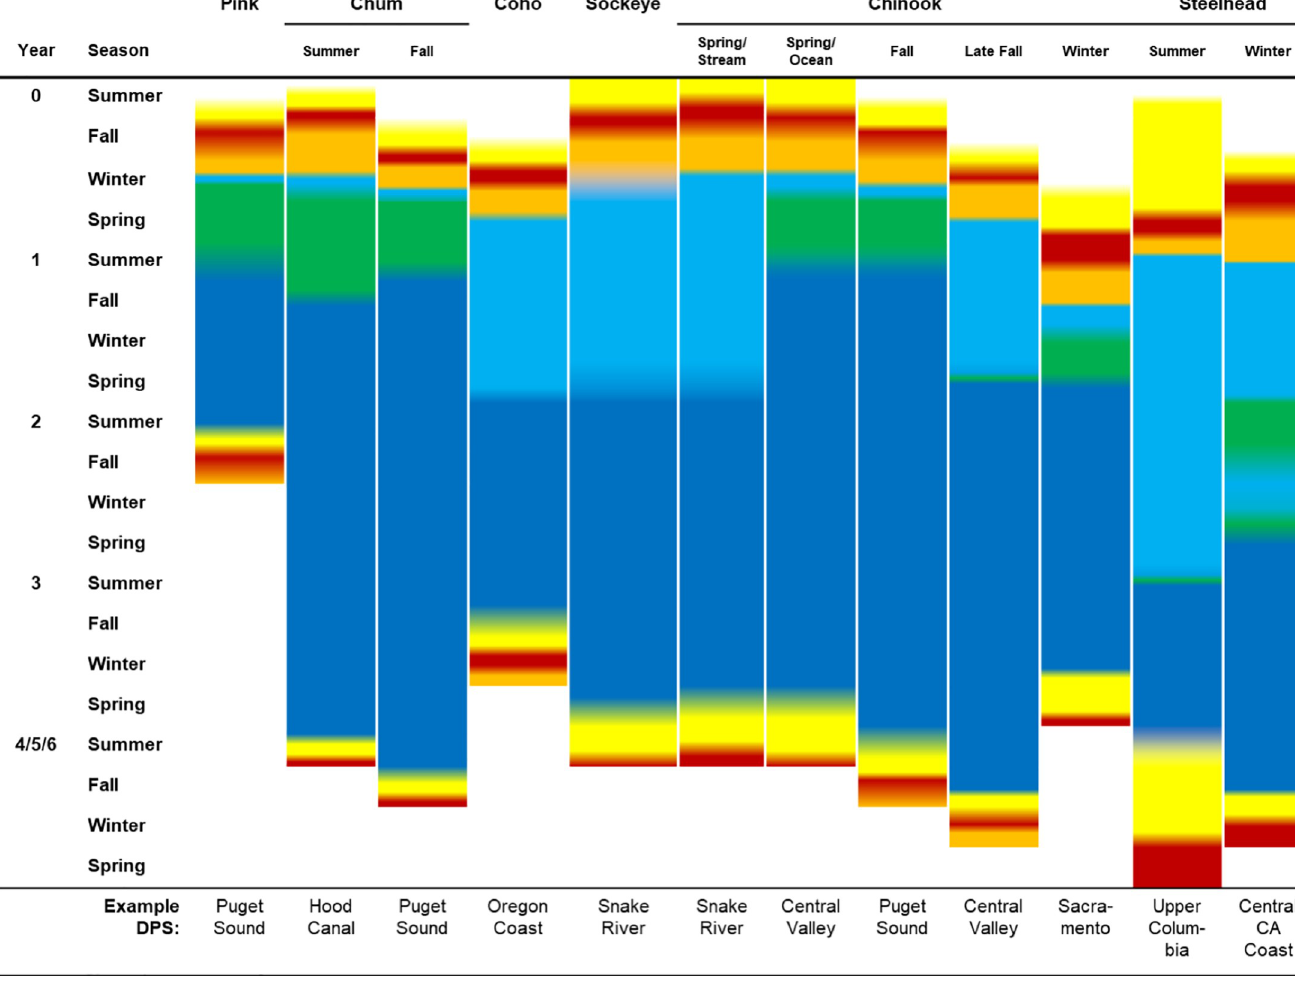
Fig 2. Schematic of Pacific salmon life histories for example ecotypes. Colors represent life stages, where yellow indicates adult freshwater migration and holding, red spawning, orange incubation, light blue juvenile freshwater rearing and migration, green estuary and nearshore rearing, and dark blue marine stage.